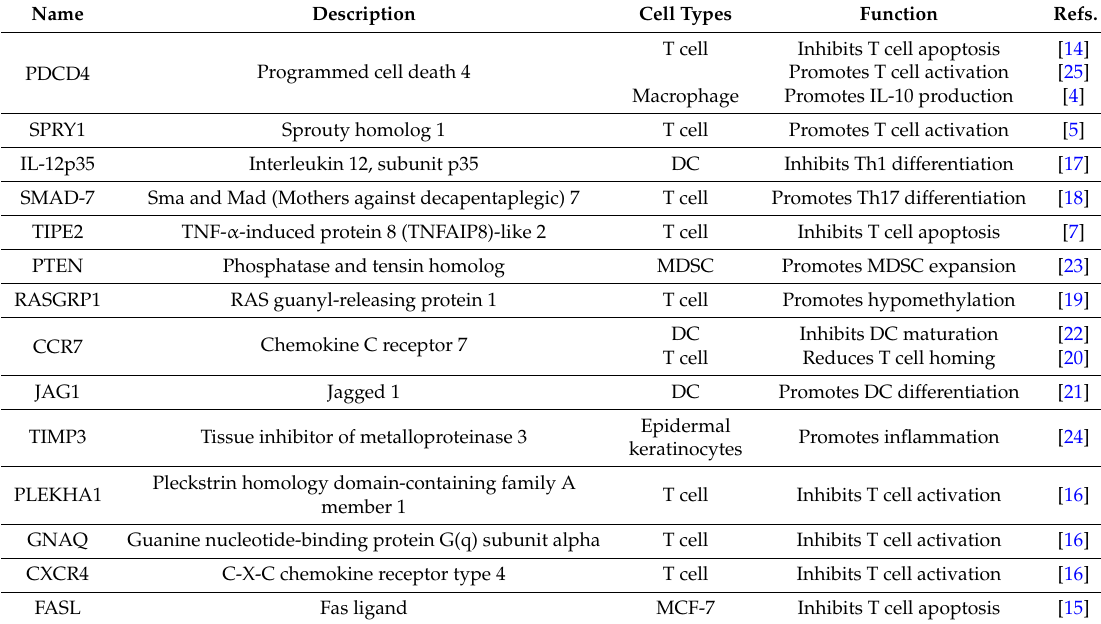
Table 2. Targets of miR-21 associated with immunity and